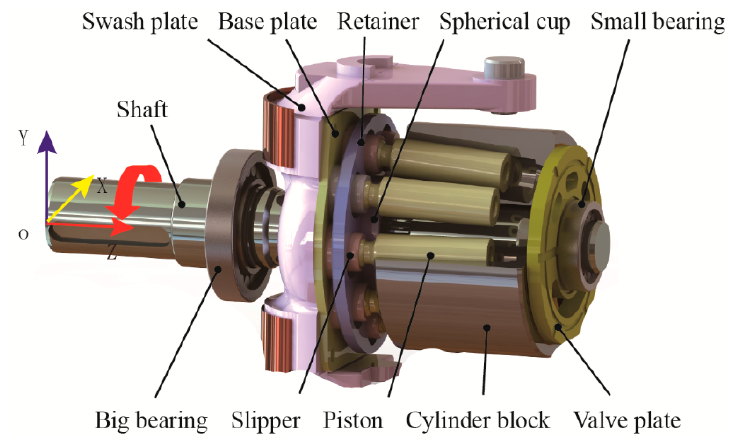
Figure 2. Typical structure of an axial piston pump.